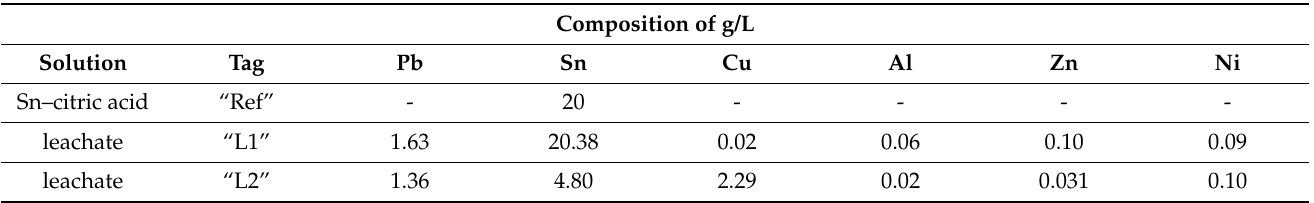
Table 1. The composition of investigated solutions. Leachates “L1” and “L2” are obtained after treatment of WEEE. Composition of g/L